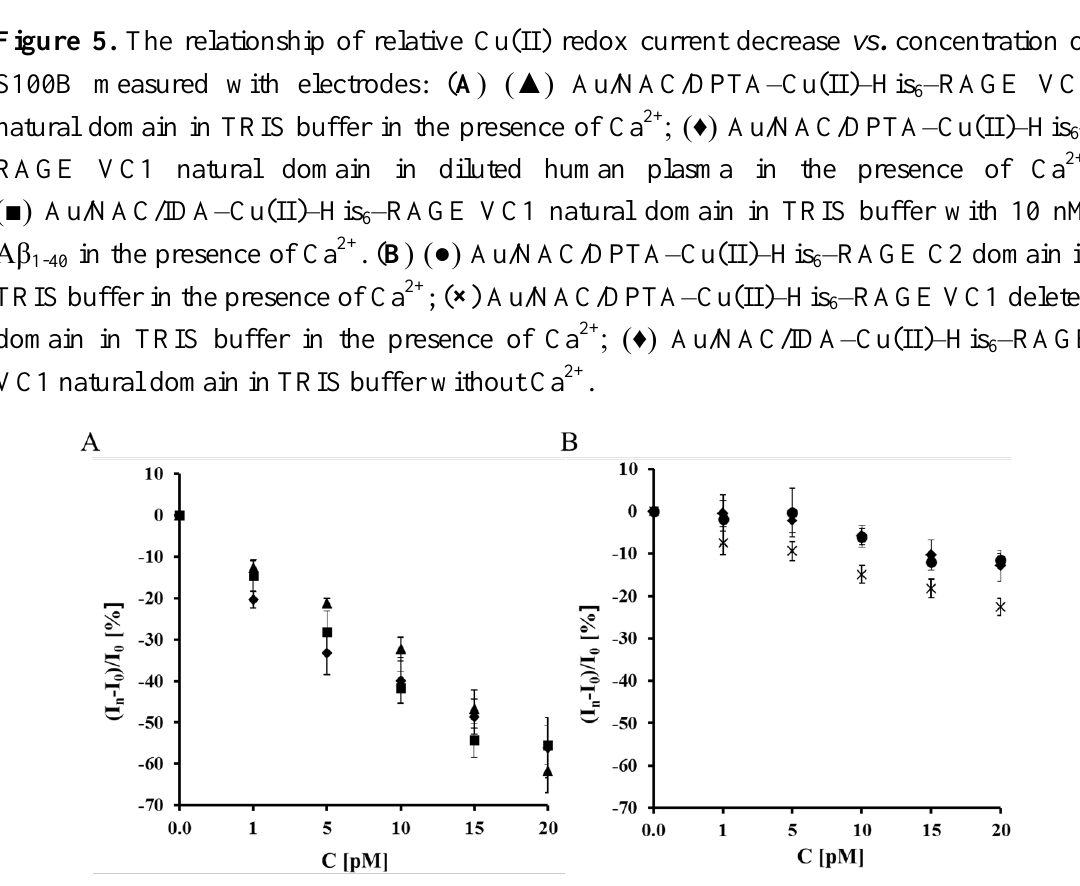
− E )/ E (%) vs. concentration of S100B measured with n o o –RAGE VC1 natural domain in TRIS 6 –RAGE VC1 natural 6 – 6 in the presence of Ca 2+ . 1-40 –RAGE C2 domain in TRIS buffer in the presence of 6 –RAGE VC1 deleted domain in TRIS buffer in the 6 –RAGE VC1 natural domain in TRIS 6